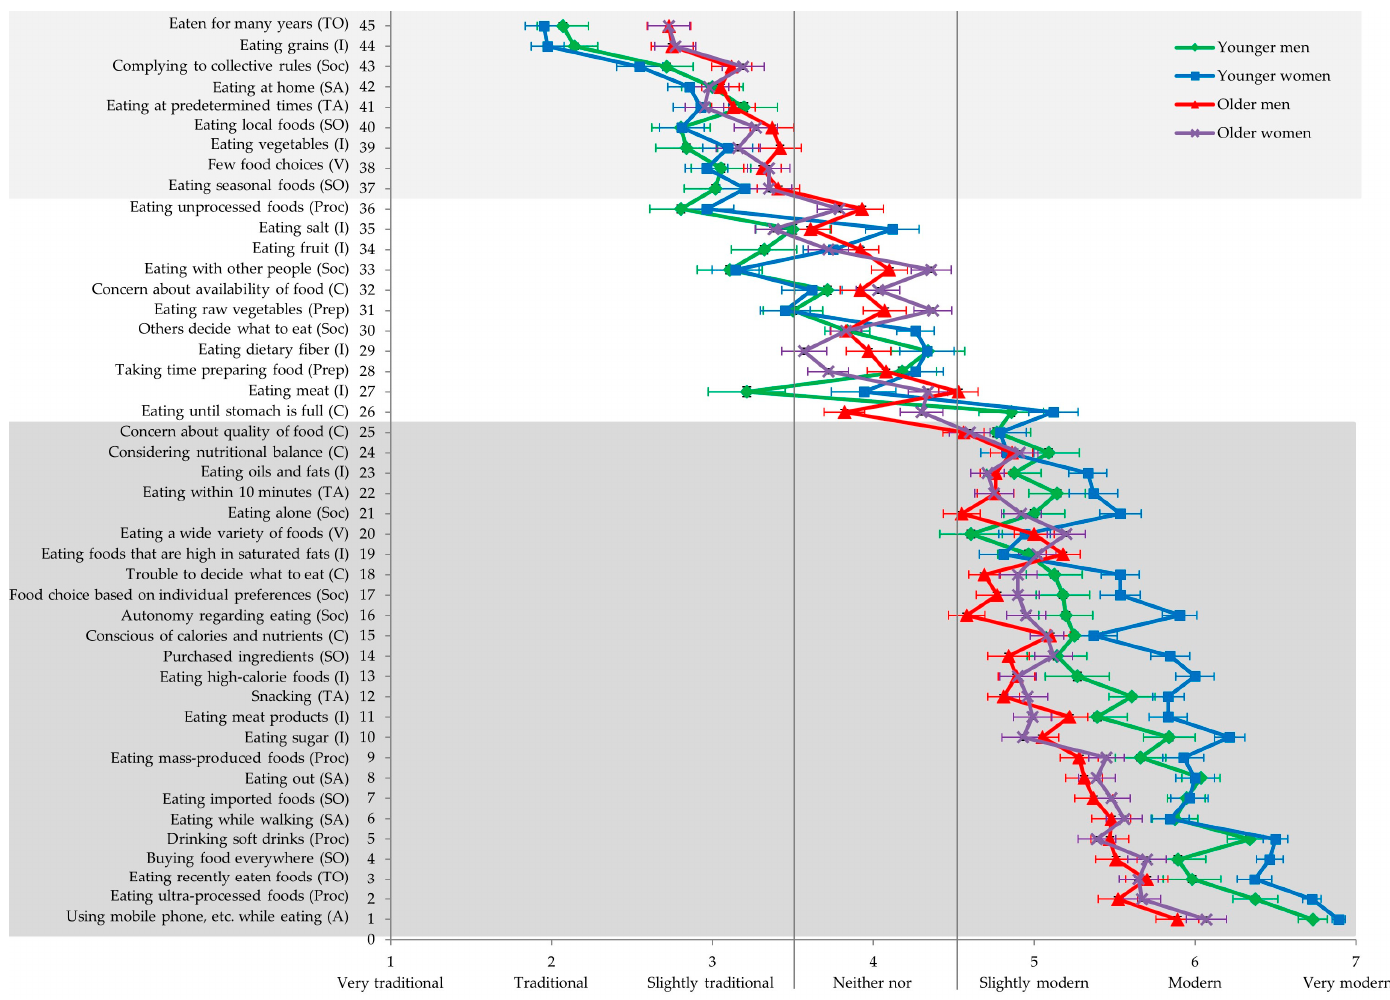
Figure 1. Mean rating of the 45 facets by age and gender. Facets are sorted by their overall mean. Error bars indicate standard errors of the mean. Related subdimensions (abbreviations, see Table 1) are written in parentheses after abbreviated items.